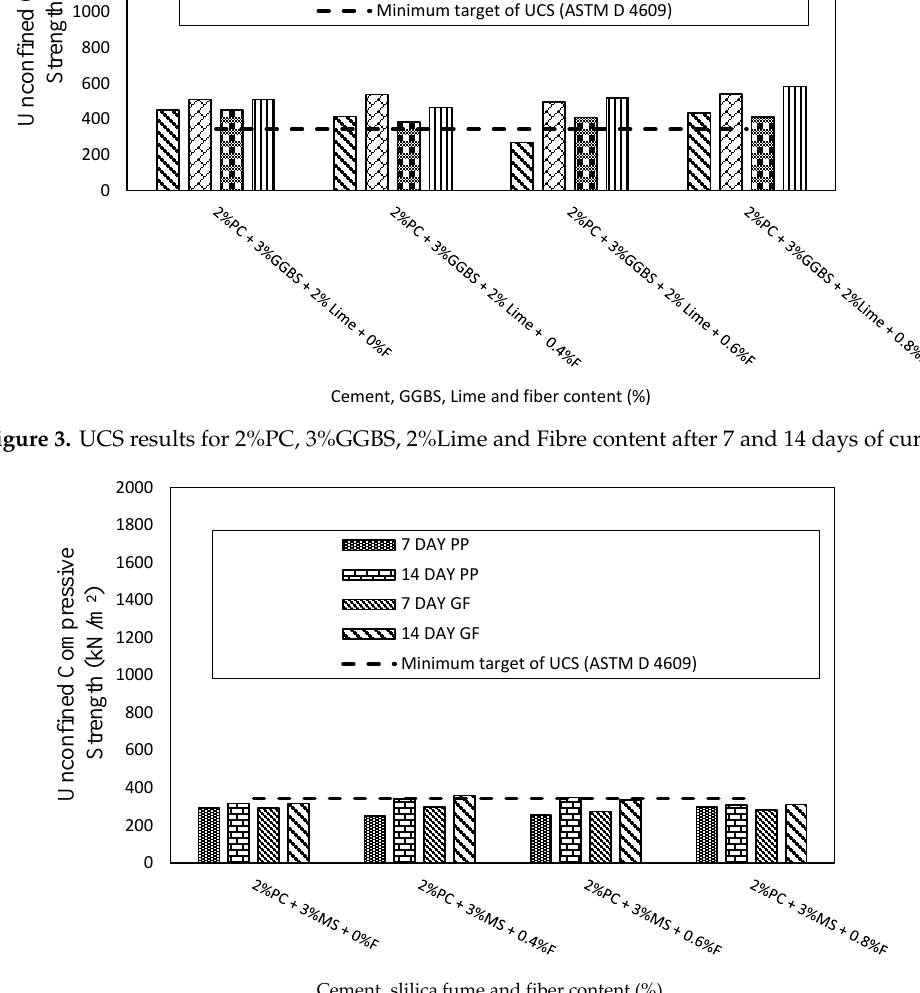
Figure 4. UCS results for 2%PC, 3%MS and fibre content after 7 and 14 days of curing .